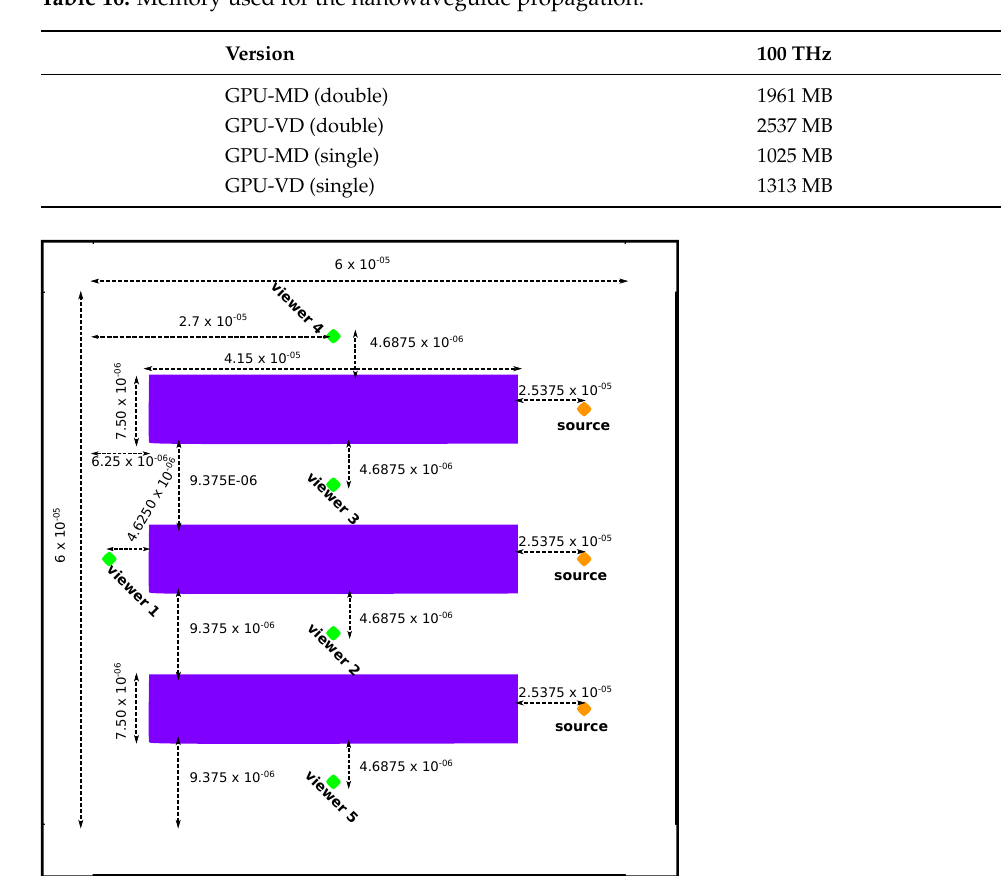
Table 16. Memory used for the nanowaveguide propagation.